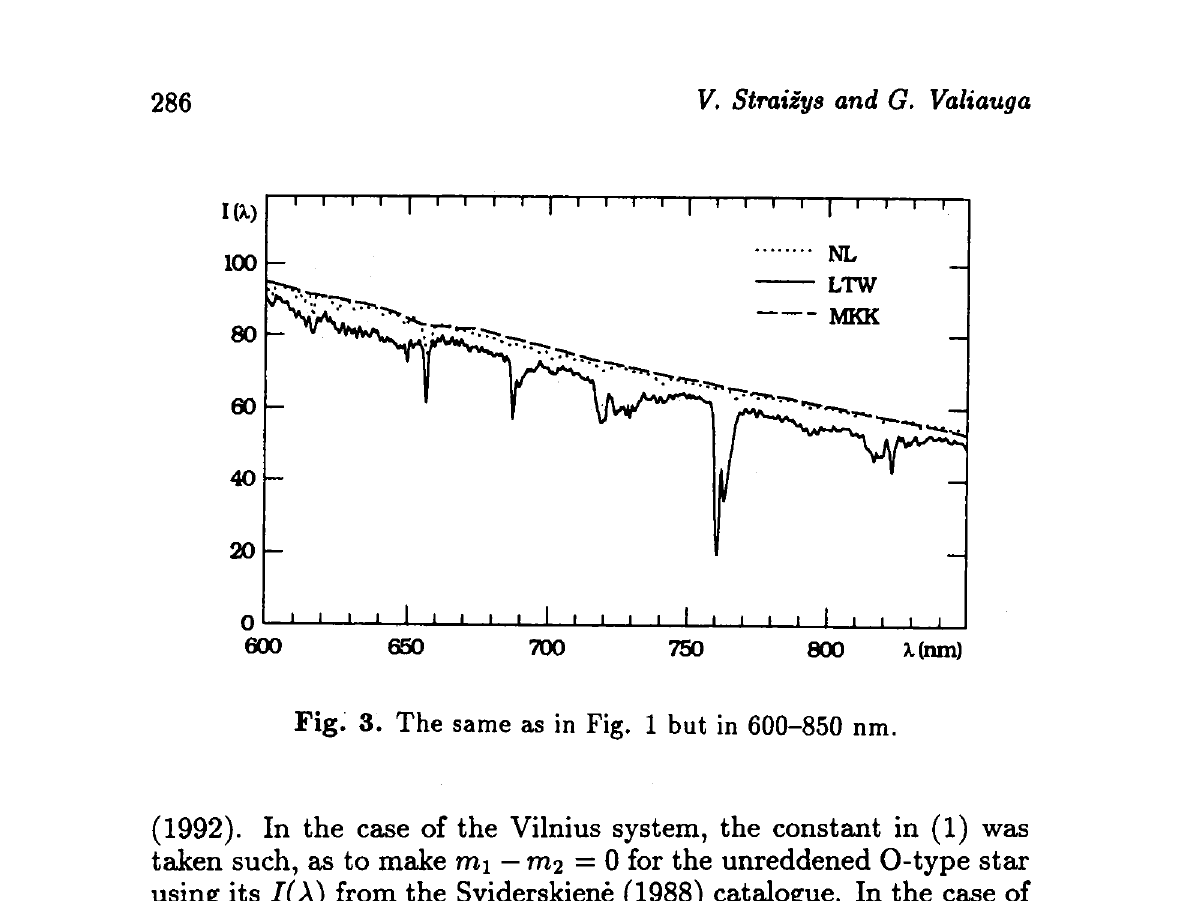
Fig. 3. The same as in Fig. 1 but in 600-850